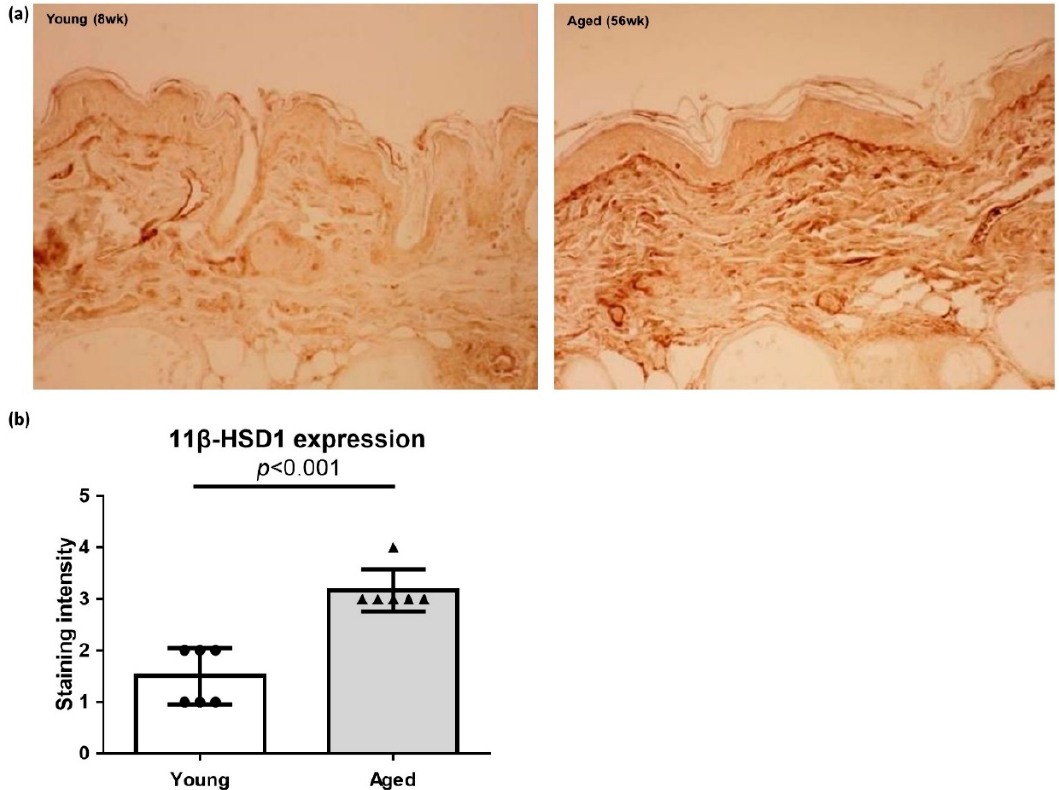
Figure 2. Immunohistochemical (IHC) staining and semi-quantitative analysis of the 11 β -hydroxysteroid dehydrogenase type 1 (11 β -HSD1) expression in the skin of young and aged hairless mice. ( a ) The 11 β -HSD1 expression is higher in the skin of aged hairless mice than in that of young mice. ( b ) The results of the semi-quantitative analysis, showing significantly higher 11 β -HSD1 expression in the aged skin than in the young skin (n = 6 each). The data are presented as the means ± SD.